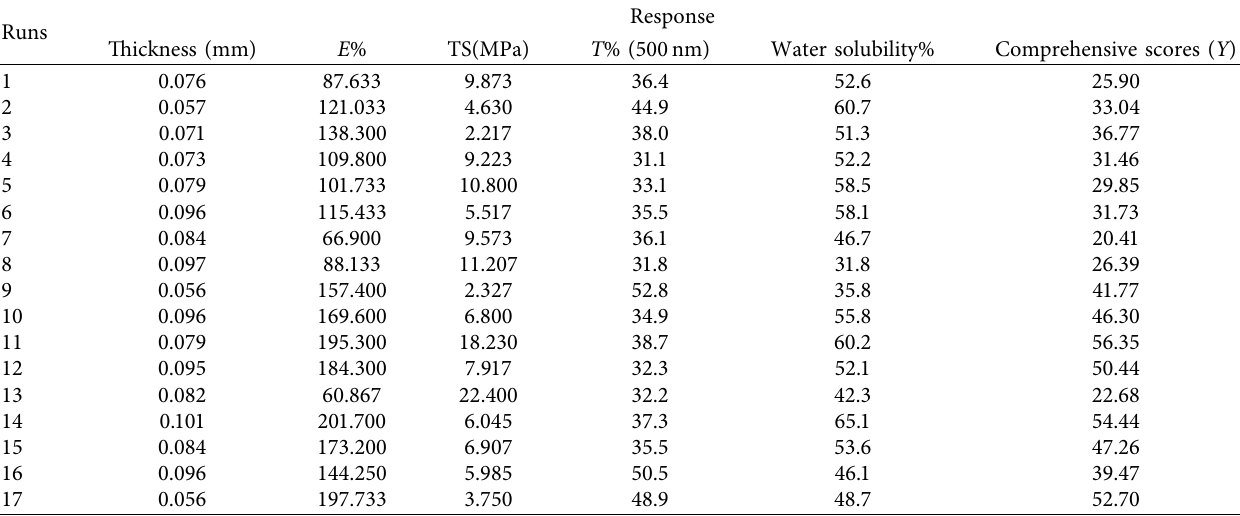
Each value represents the mean value of three determinations.